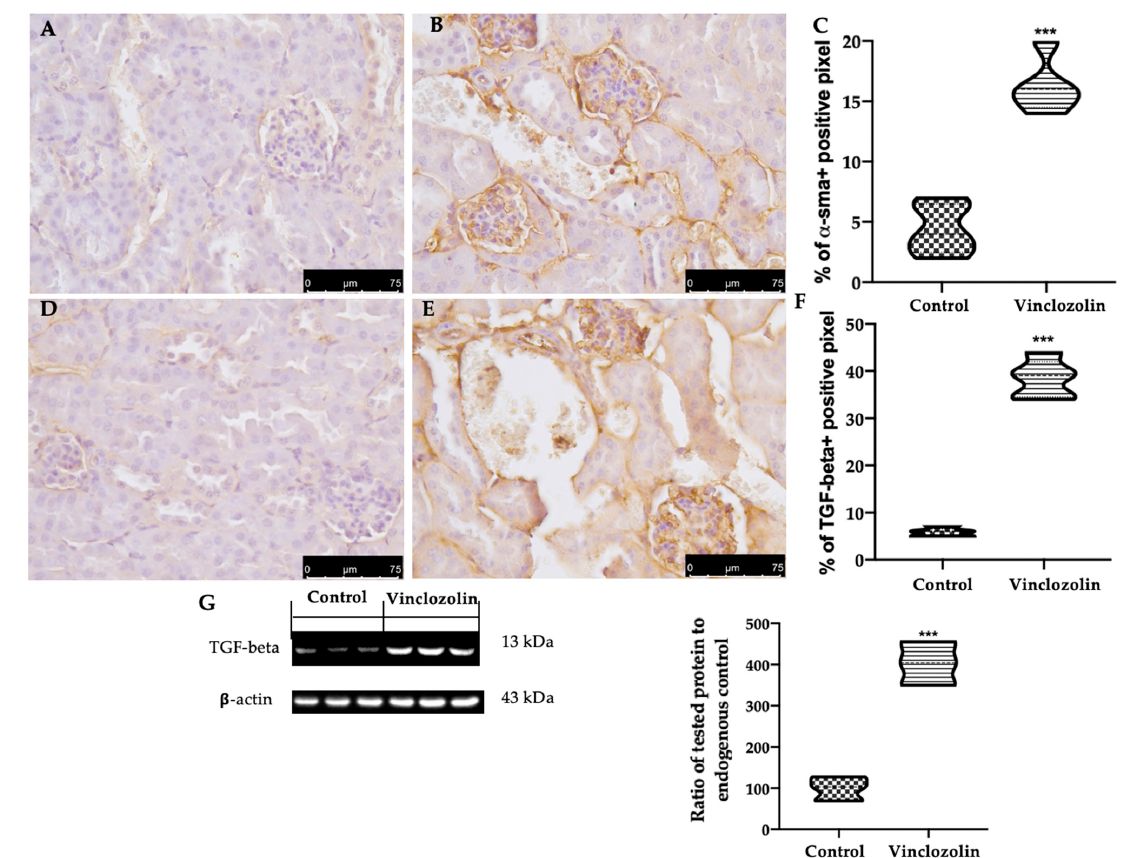
Figure 5. Effects of vinclozolin exposure on kidney fibrosis: Immunohistochemical analysis of α -sma: ( A ) control; ( B ) vinclozolin; ( C ) % of α -sma+ positive pixel, immunohistochemical analysis of TGF- β ; ( D ) control; ( E ) vinclozolin; ( F ) % of TGF- β + positive pixel. Western blot analysis of TGF- β expression ( G ). Magnification 40 × . A p -value less than 0.05 was considered significant. *** p < 0.001 vs. control.